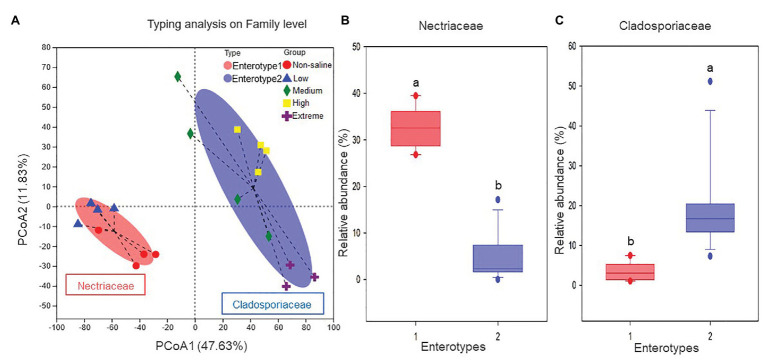
The enterotype analysis for five different salinized soils: (A) the clustering on the first two principal components, and the proportions of fungal taxa characteristic of (B)
Nectriaceae and (C)
Cladosporiaceae.